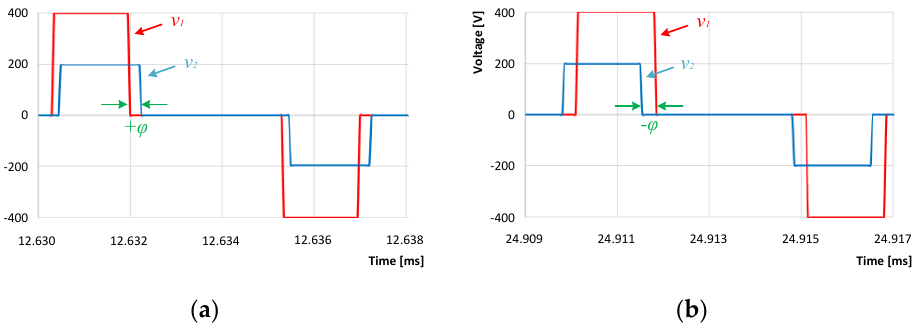
Figure 5. Voltage waveforms in the windings of the high-frequency transformer of the DAB power converter with power flow from the: ( a ) primary to the secondary side ( φ > 0); ( b ) secondary to the primary side ( φ < 0).